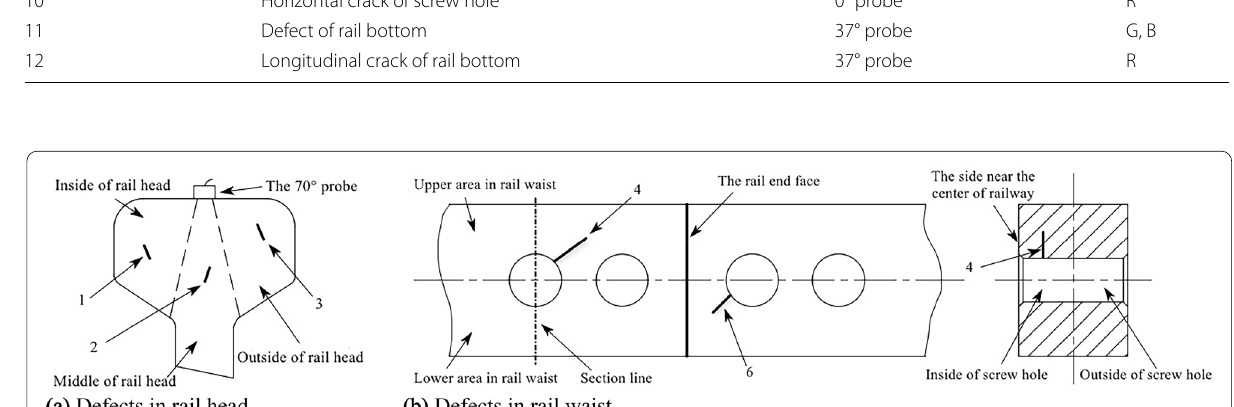
Figure 4 Position diagram of some